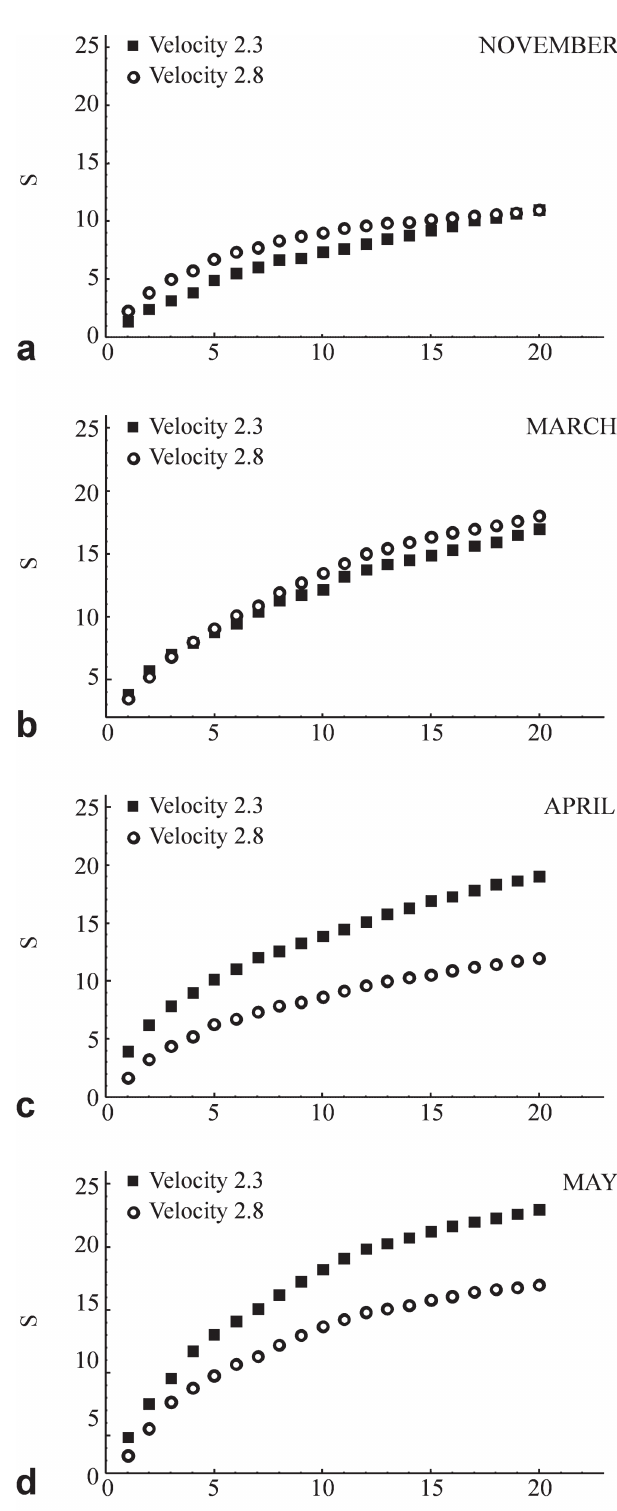
Fig. 5. Species richness (rarefaction curves) in the Lajeado fish ladder under flow velocities of 2.3 and 2.8 m.s -1 in the ladder, during months when the discharge was